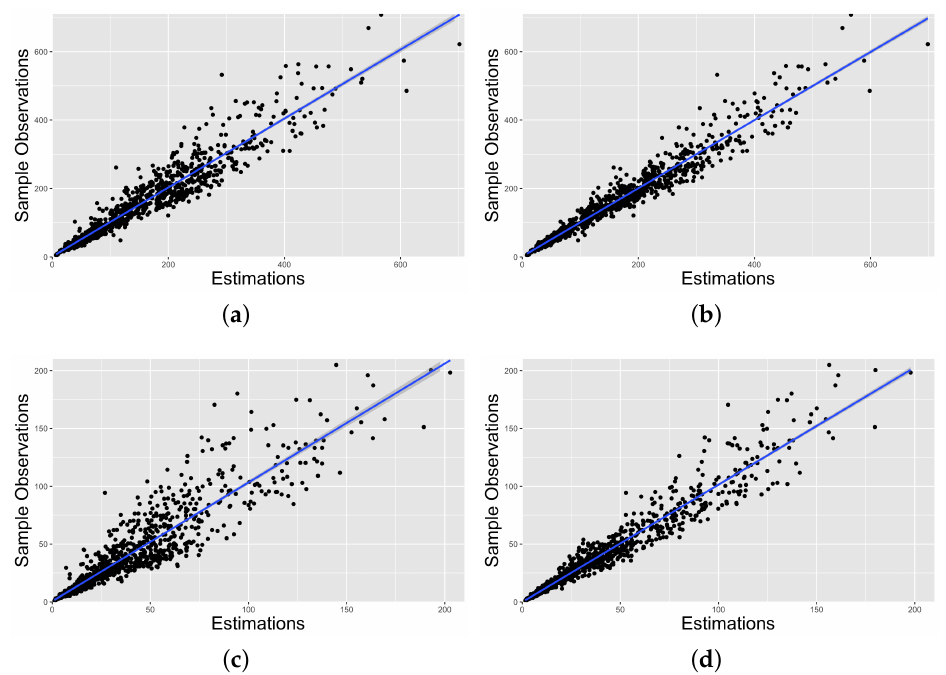
Figure 2. Observations vs. Estimations using Linear Regression model and LME model. ( a ) Linear model predict rice fresh weight; ( b ) LME model predict rice fresh weight; ( c ) Linear model predict rice dry weight; ( d ) LME model predict rice dry weight.